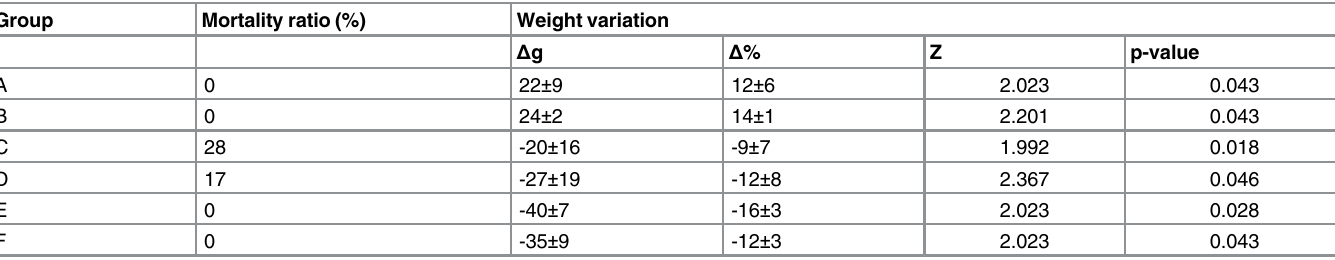
Table 2. Cisplatin toxicity expressed as mortality ratio and weight variations. Group